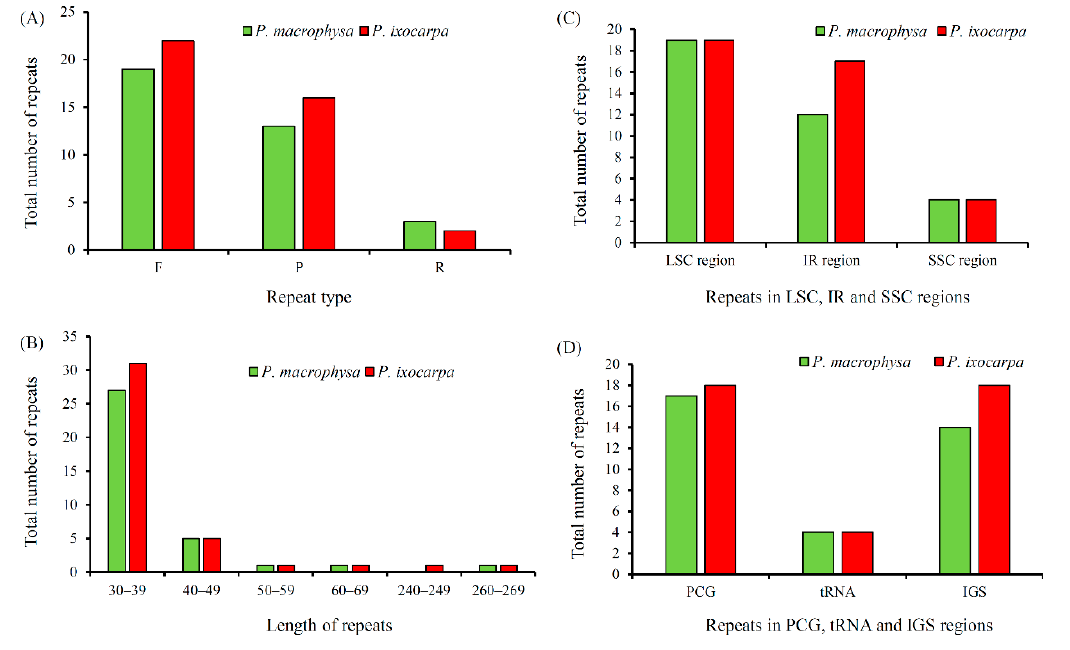
Figure 3. The repeat sequences in cp genomes of PMA and PIX. ( A ), repeat type; ( B ), length of repeats; ( C ), repeats in LSC, SSC and IR regions; ( D ), repeats in PCG, tRNA and IGS regions.